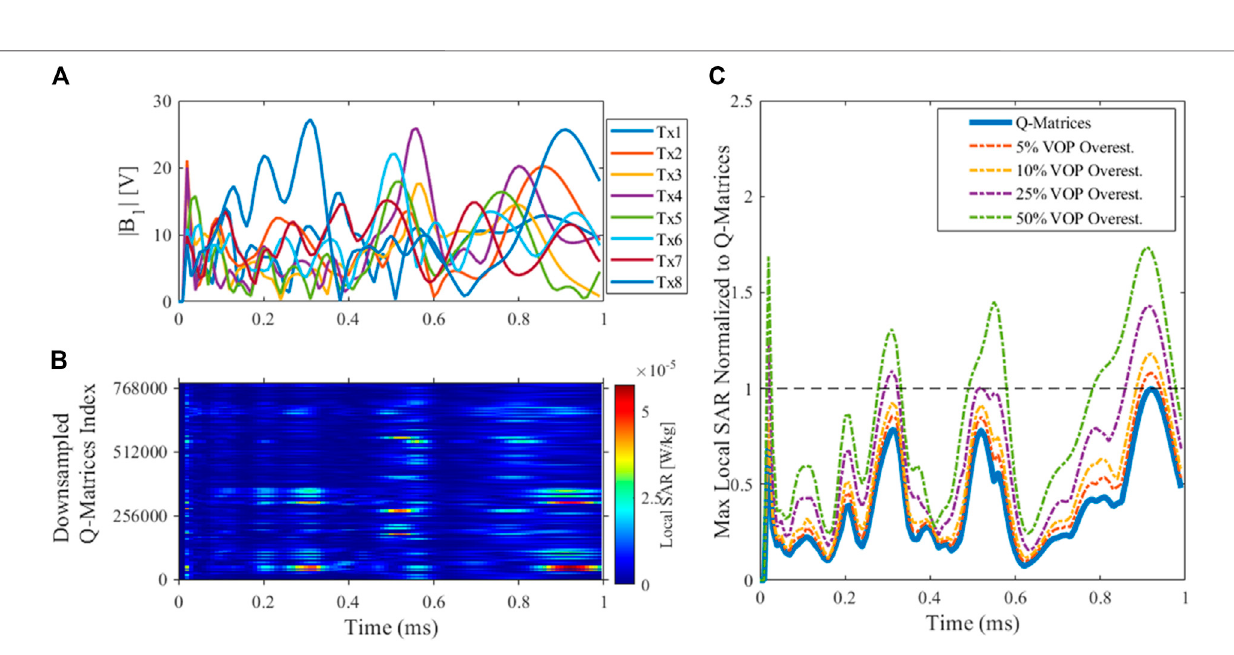
with distinct amplitude and phase con fi gurations, different Q-matrix voxel locations deposit more local SAR. Figure 9C compares the normalized maximum local SAR at each time point of the UP excitation for the Q-matrices and various VOP compressions: 5, 10, 25, and 50% worst case SAR